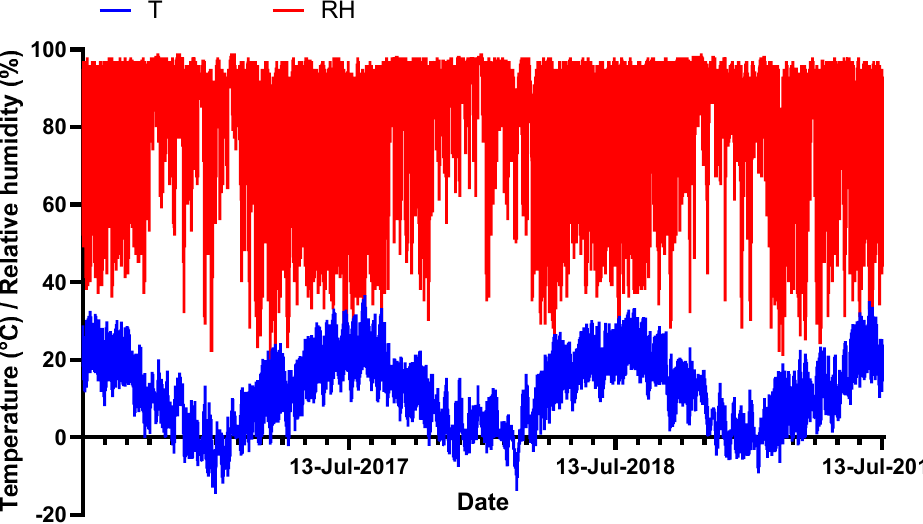
Figure 3. Temperature (T) and relative humidity (RH) in the nearby weather station between 13th of July 2016 and 15th of July 2019. Each curve represents 105,000 measurements.